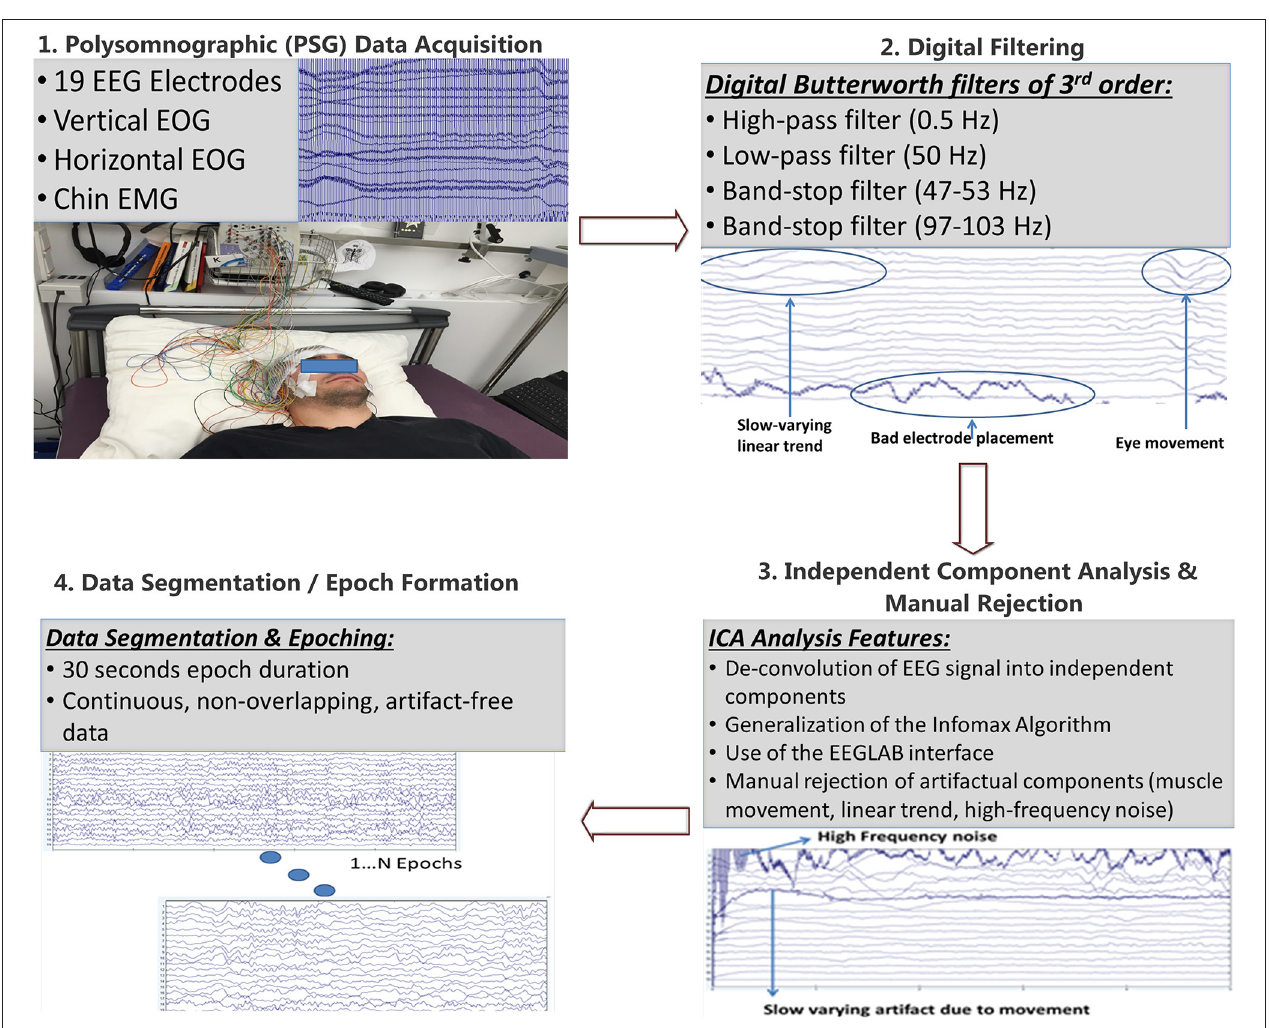
FIGURE 1 | Pre-processing pipeline: After the EEG signal has been recorded it is segmented into five parts which are digitally filtered through Butterworth filters of 3rd order. Then, Independent Component Analysis is performed through the EEGLAB graphical interface and components corresponding to industrial noise, linear trends, muscle movements, bad electrode placement, eye blinks are visually rejected. Finally, epochs of 30s of continuous, non-overlapping, artifact free data are formed according to the guidelines of the American Association of Sleep Medicine